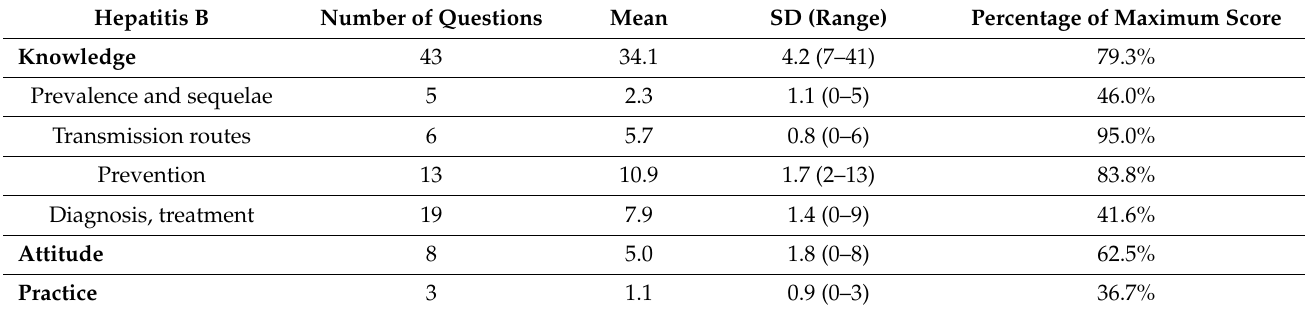
Table 5. Mean score of knowledge, attitudes and practices ( n =